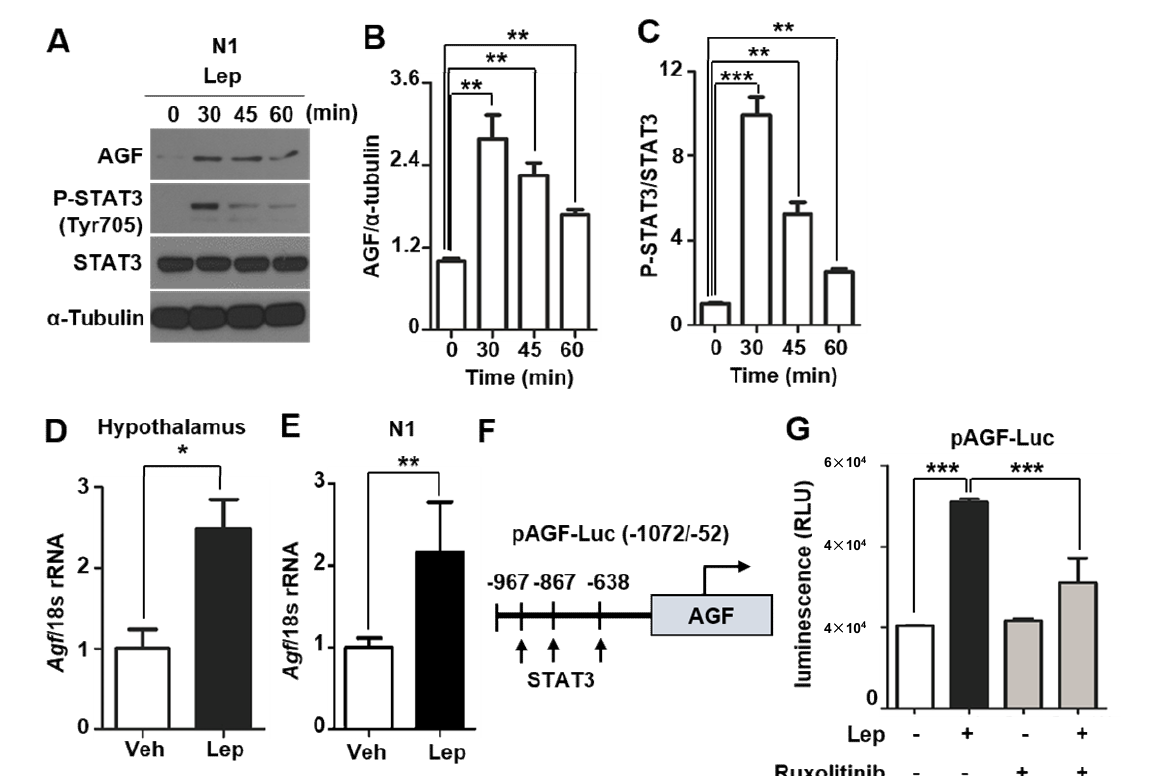
Figure 4. AGF promoter activity is increased by leptin. ( A ) AGF protein level in N1 cells, determined after treatment with 100 ng/ml leptin for 0, 30, 45 and 60 min. ( B , C ) AGF and pSTAT3 band intensities, measured using the ImageJ program. ( D , E ) AGF mRNA expression level in the hypothalamus ( D ) and in N1 cells ( E ) after leptin administration, normalized to 18s rRNA level, as determined by qPCR ( n = 5/group). ( F ) Location of STAT3 binding sequences in the AGF promoter ( − 1072 to − 52 bp). ( G ) AGF promoter activity, measured in N1 cells transfected with an AGF promoter-luciferase reporter plasmid after a 45 min incubation with leptin (100 ng/ml). Cells were pre-incubated in the presence or absence of the JAK2 inhibitor, ruxolitinib (1 µ M) for 1 h. N1 cells were harvested and luminescence was measured. Data represent means ± SEM (* p < 0.05, ** p < 0.01, *** p <